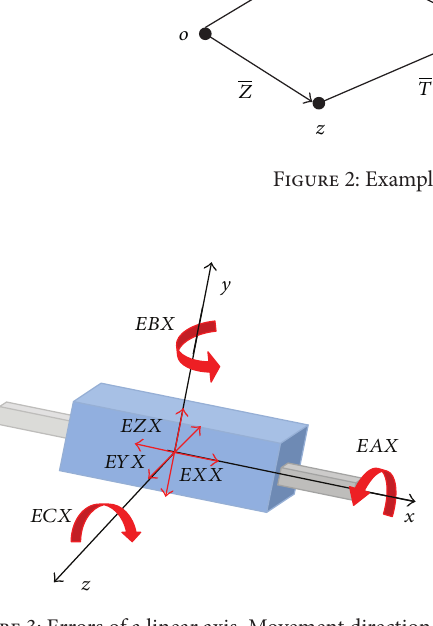
the movement of axes 𝑋 , 𝑌 , and 𝑍 about axes 𝑥 , 𝑦 , and 𝑧 , whereas the axes of rotation are represented by the rotation of A, B, or C about axes 𝑥 , 𝑦 , and 𝑧 , respectively. Similarly, 𝑇 represents the difference ( 𝑥 , 𝑦 , 𝑧 ) between the last axis movement of the tool and the workpiece 𝑊 as presented by Tong et al.